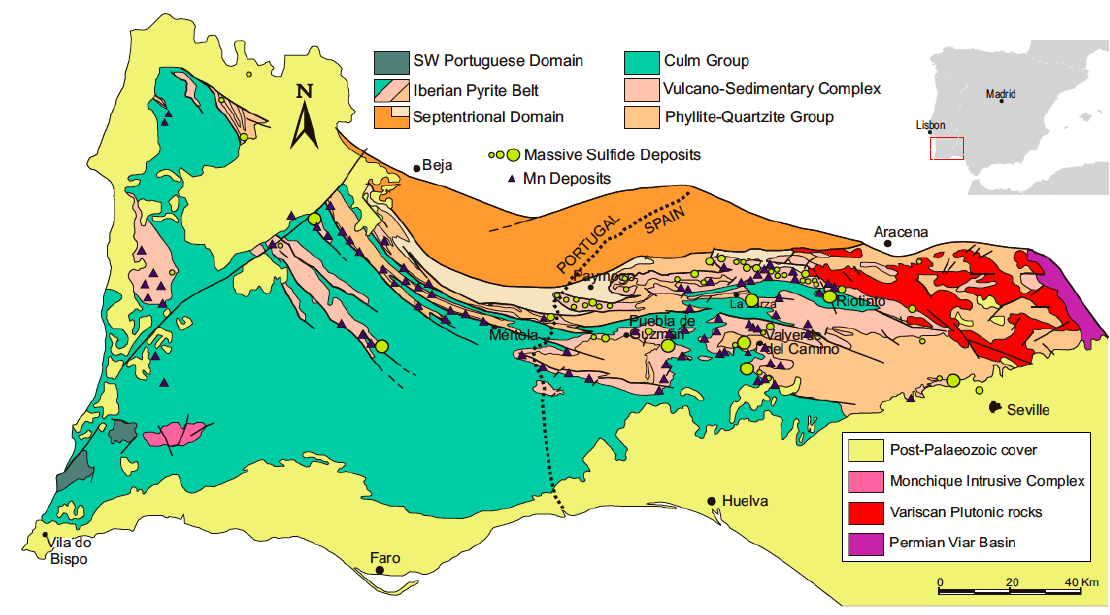
Figure 1. Geologic map of the South Portuguese Zone including the location of the most important massive sulfide deposits within the Iberian Pyrite Belt. The sketch at the top right corner indicates the location of the South Portuguese Zone within the Iberian Peninsula (modified from Sáez [38]).